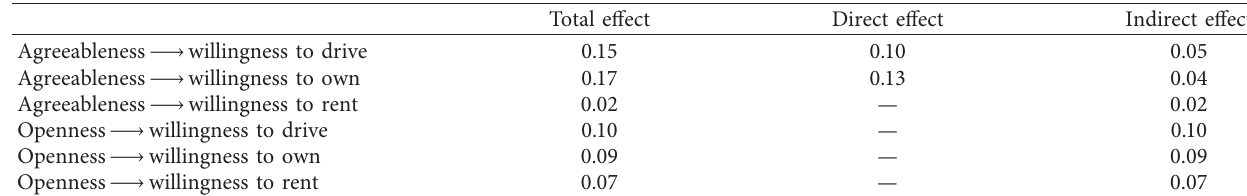
Figure 2: Revised path model of the variables with significantly standardized regression estimates. Table 5: Standardized effects from the path